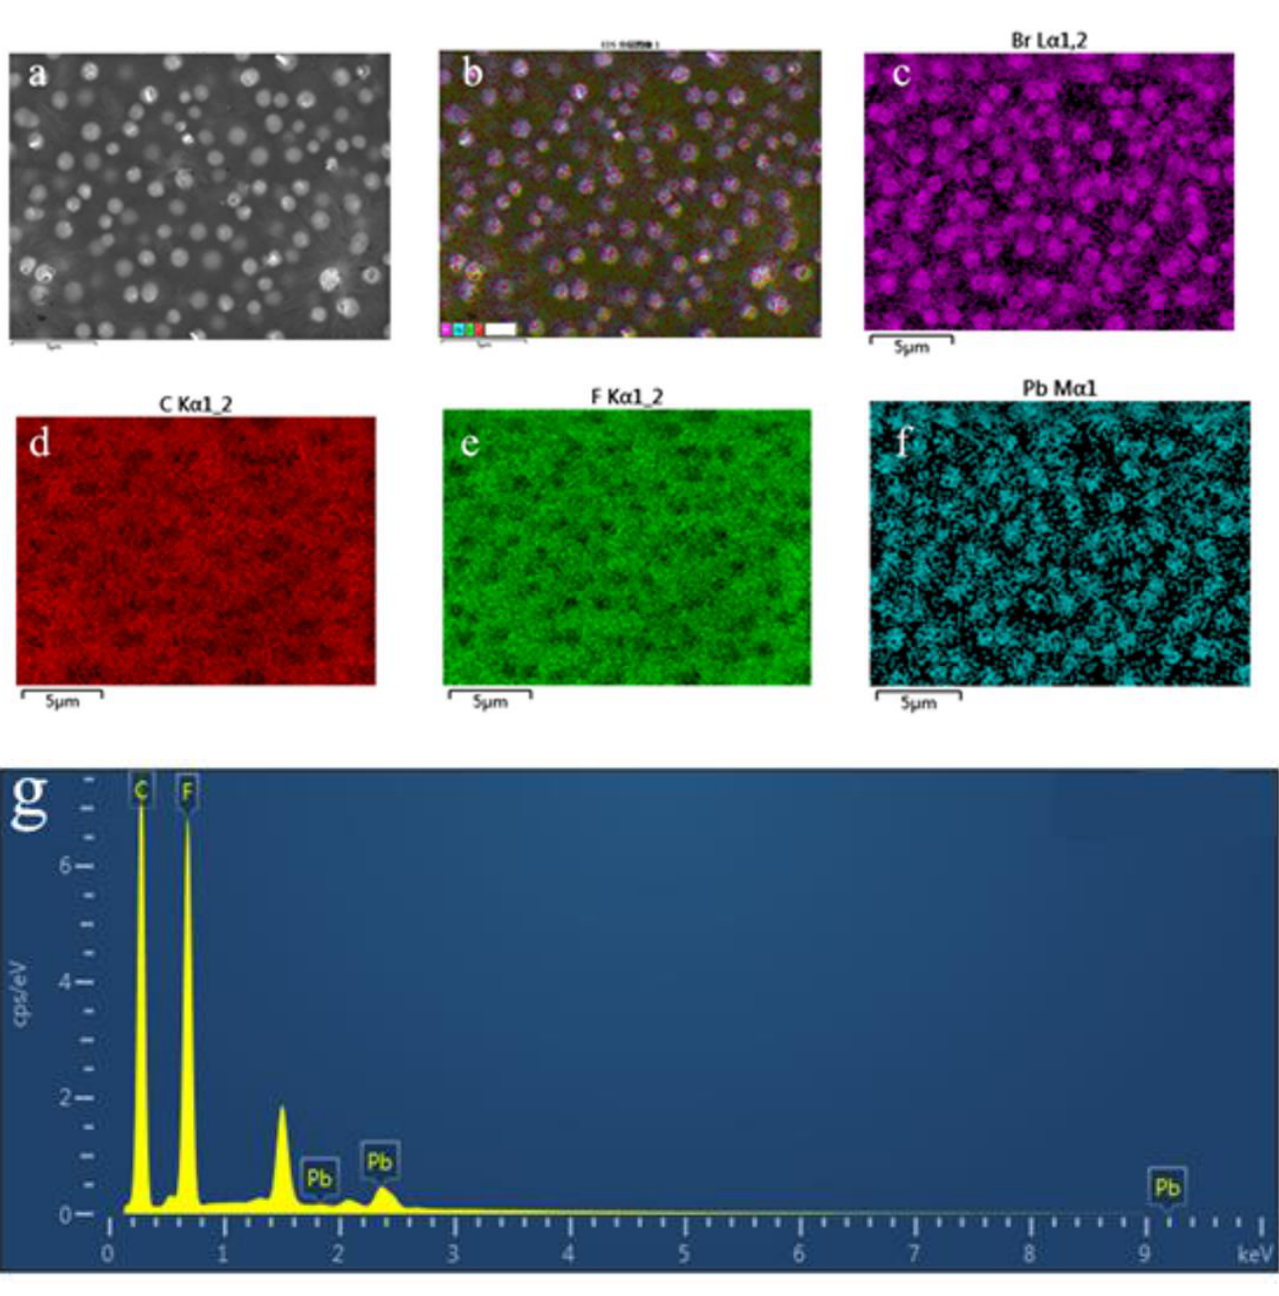
Figure 2. The 0-3 type piezoelectric thin film X-ray energy spectrum analysis: ( a ) energy spectrum surface scan area, ( b – f ) EDS element distribution map, ( g ) X-ray energy spectrum. Table 2. Selected element types and content percentages obtained by X-ray spectroscopy of 0-3 piezoelectric films.